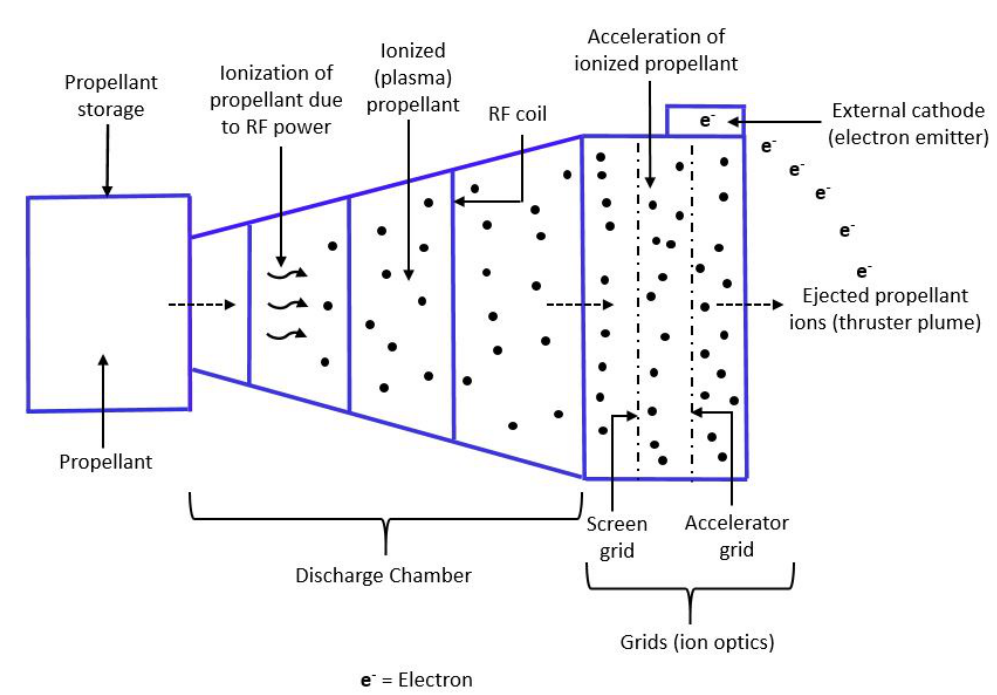
Figure 5. Schematic of a Radio Frequency (RF) Ion Propulsion